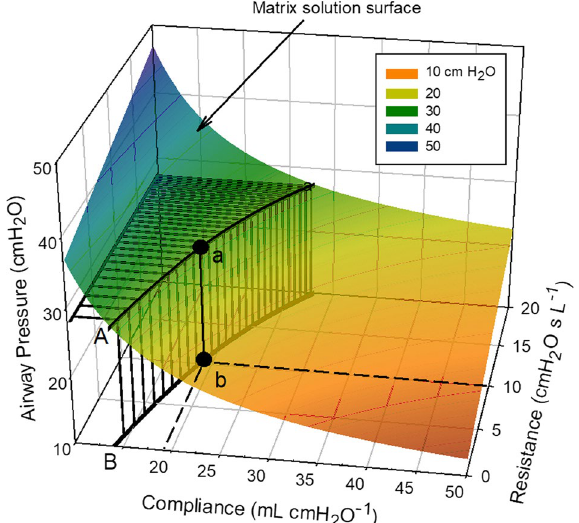
Fig. 1 Schematic of the numerical method used to solve the respiratory system equation of motion for static compliance ( C rs ) and airway resistance ( R rs ). In this example, the solution matrix was developed for Δ V ( t k ) 300 mL, F aw ( t k ) 32 L min − 1 , and PEEP a 5 cmH 2 O and shown graphically as a three-dimensional = = · = surface bounded by C rs values ranging from 10 to 50 mL cmH 2 O − 1 and R rs from 0 to 20 cmH 2 O s L − 1 . This · · · surface encompasses all possible combinations of P aw , C rs and R rs capable of satisfying Eq. 2 for a given set of Δ V , F aw , and PEEP a measurements made at time t k during insufflation. P aw , also measured at t k and equal in this example to 27 cmH 2 O, further restricts the solution of Eq. 2 to lie along path ( A ). This path is defined by surface values coinciding with the measured P aw, with point ‘a’ referring to the still unknown solution of Eq. 2. Projecting path A onto the C rs – R rs plane results in a two-dimensional function ( B ) relating C rs to R rs . Here ‘b’ represents the unique solution of Eq. 2 defining the values for C rs and R rs for the breath under